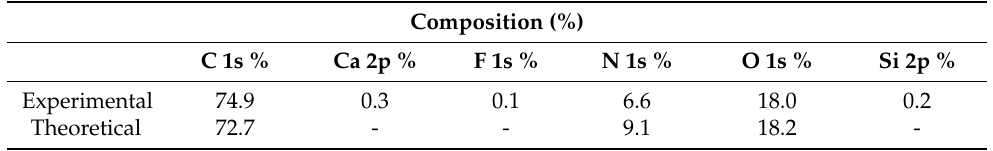
Table 6. XPS elemental composition of PDA coating as an atomic